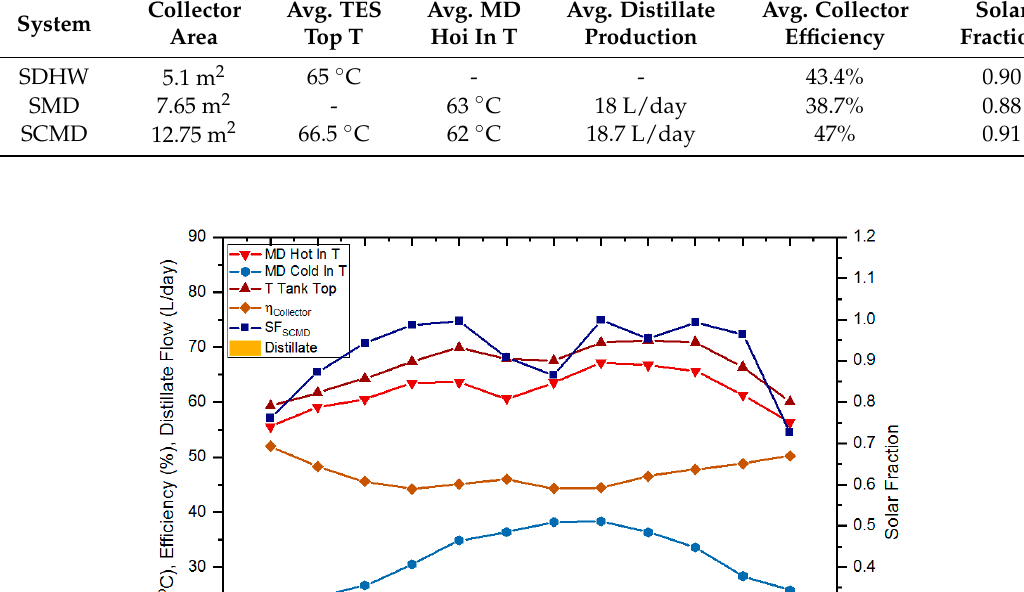
Table 5. Comparative system analysis based on annual simulation data.